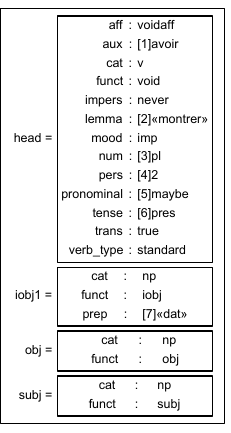
Frigram: a French Interaction Grammar